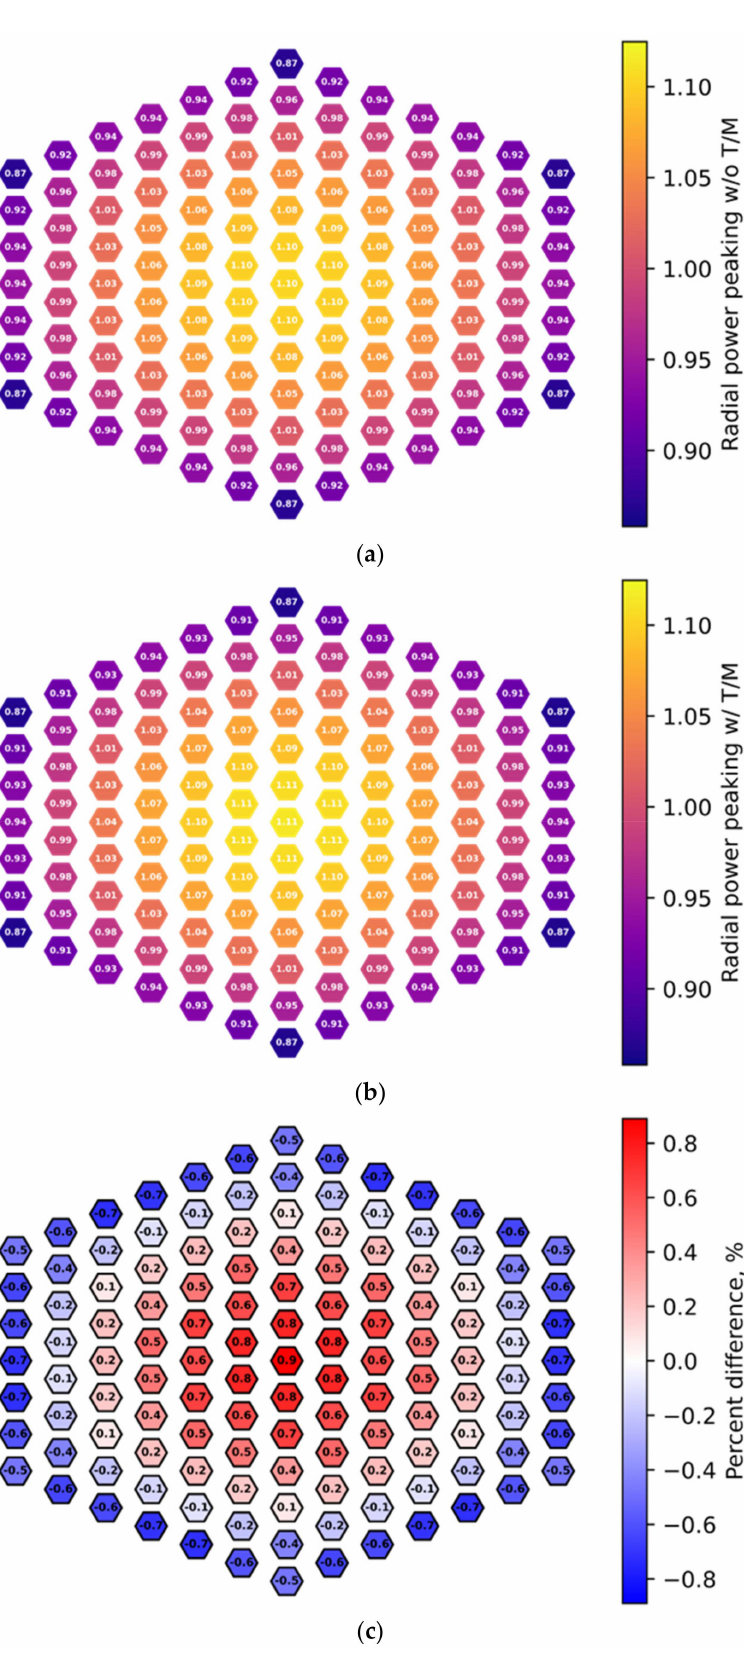
Figure 8. Comparison of radial power peaking ( a ) w/o T/M feedback; ( b ) w/ T/M feedback; ( c ) percent